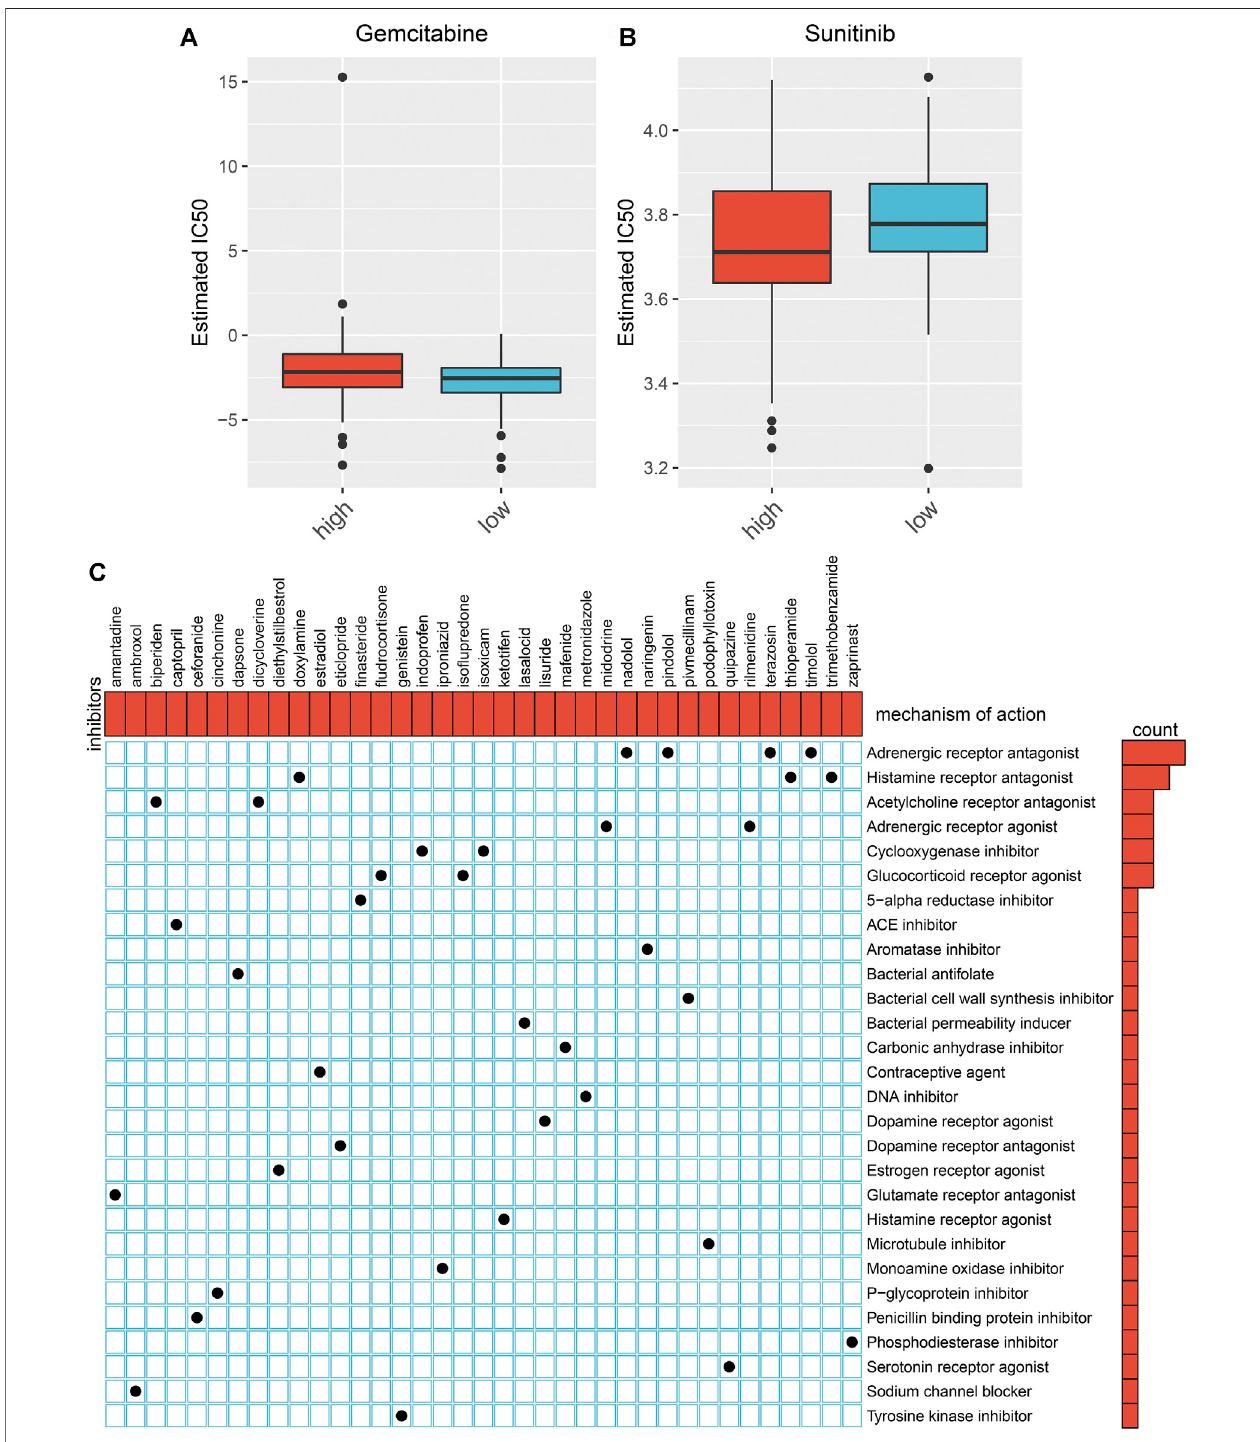
FIGURE 6 | Prediction of chemotherapy bene fi t and small molecular agents based on the aging-related gene model. (A, B) Comparison of IC50 value of gemcitabine and sunitinib in high- and low-risk subgroups. (C) Shared molecular mechanisms among small molecular agents via MoA.